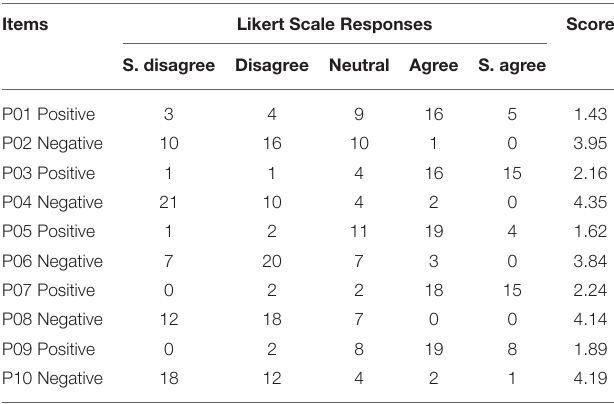
TABLE 4 | Frequencies of user responses to questionnaire items (i.e., propositions, such as “P1”) from the System Usability Scale (SUS) (Brooke, 1996).